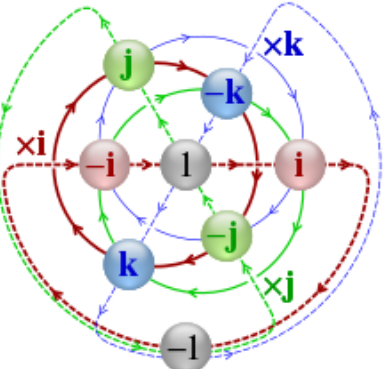
Figure 7. Quaternion visualization between axes (X, Y, Z) on a smartwatch-embedded gyroscope sensor and accelerometer